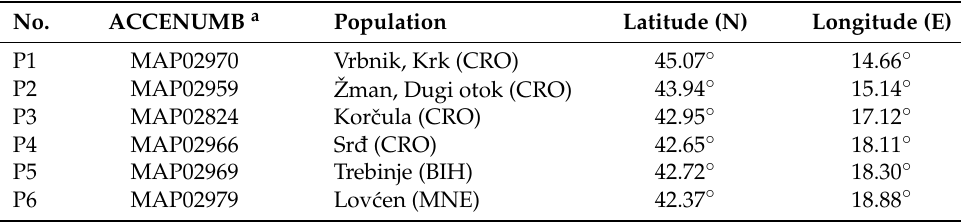
Table 1. Geographical data of sampling locations of Dalmatian pyrethrum.